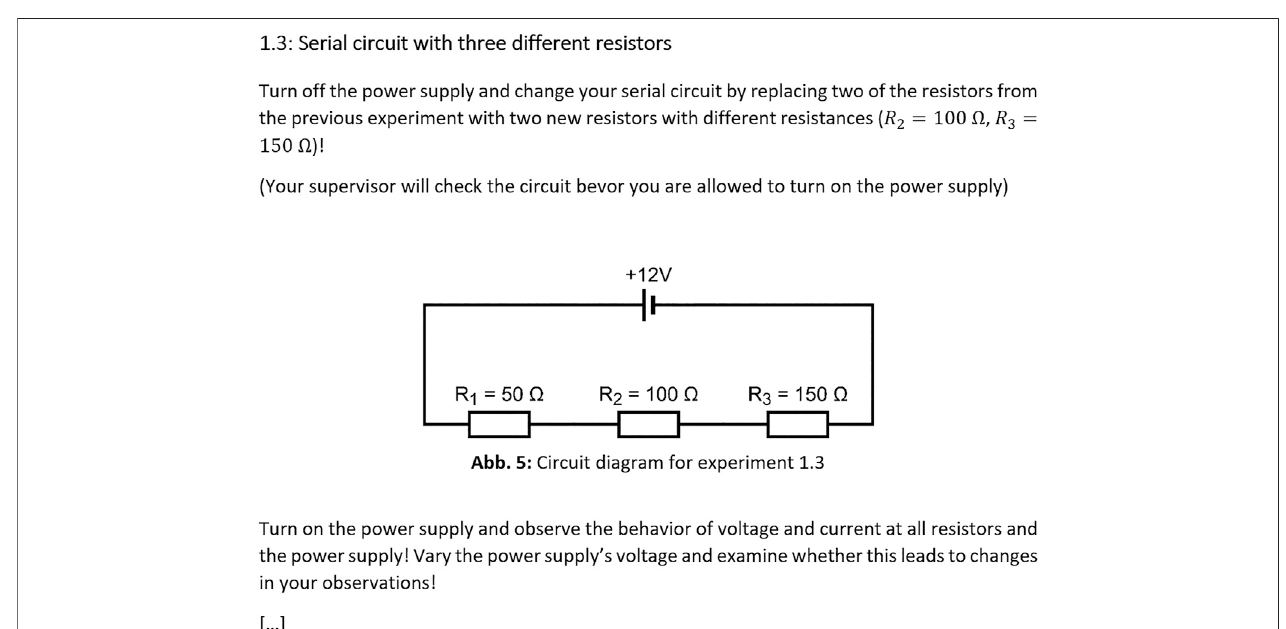
FIGURE 1 | Example of the experimental task description (translated for this publication, corresponds to the circuits given in Figures 2 , 3 ).